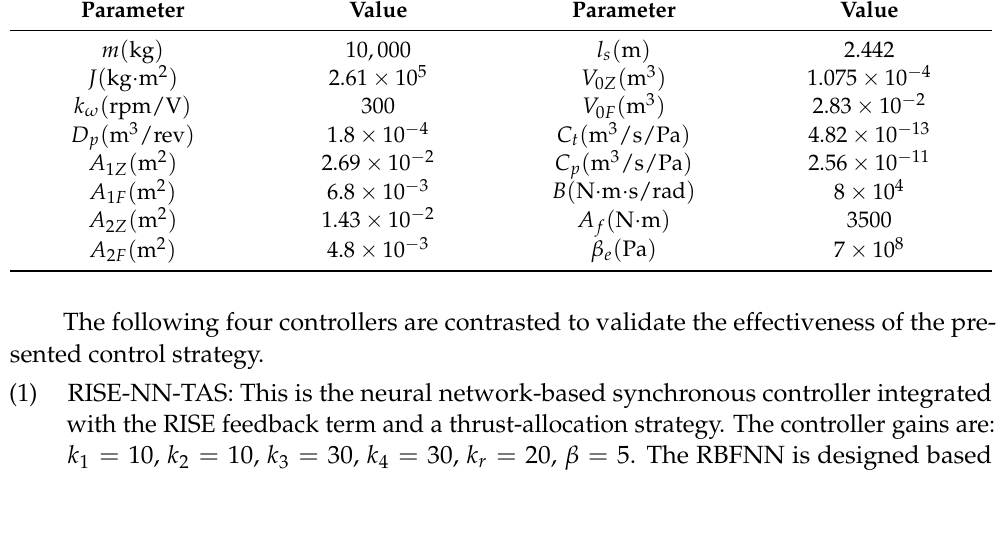
Table 1. Physical parameters of the dual-cylinder erection mechanism. Parameter